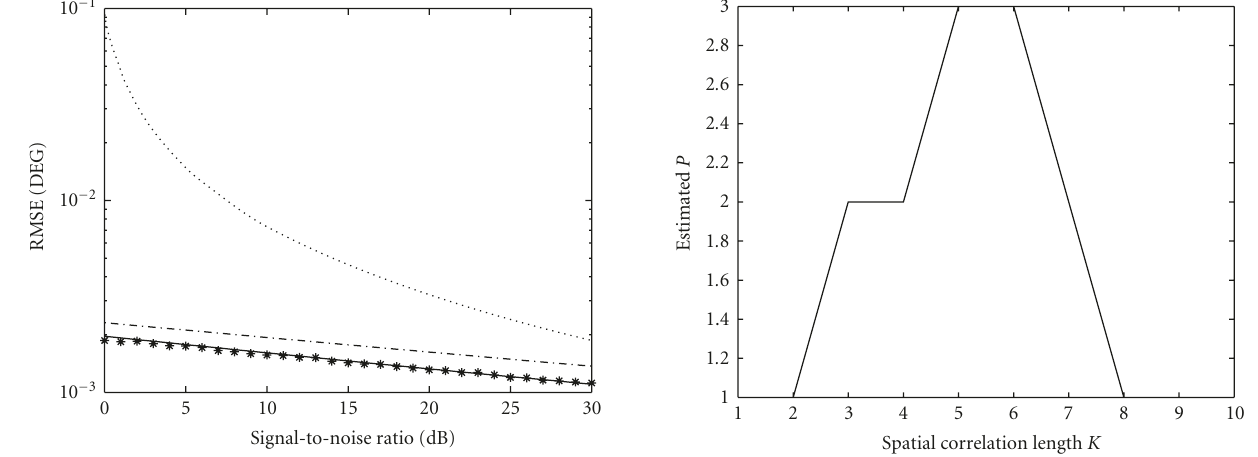
Figure 4: RMSE versus signal-to-noise ratio, K = 5: Cramer- Rao bound (stars) from [22], proposed method (solid), maximum likelihood (dashed) [5], and MUSIC method in [16] (dots).